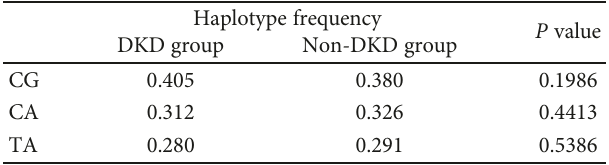
Table 4: Haplotype analysis of block 1 in the study